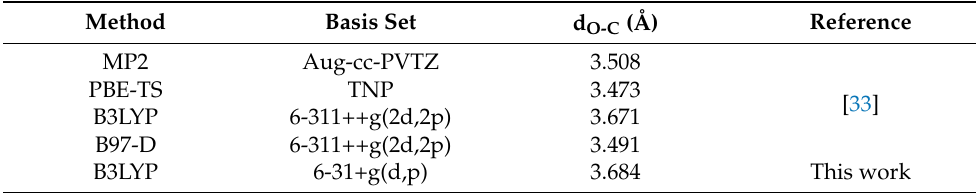
Table 1. The equilibrium distances in the stable geometries of the mono-cages with a CH 4 guest molecule, obtained by different